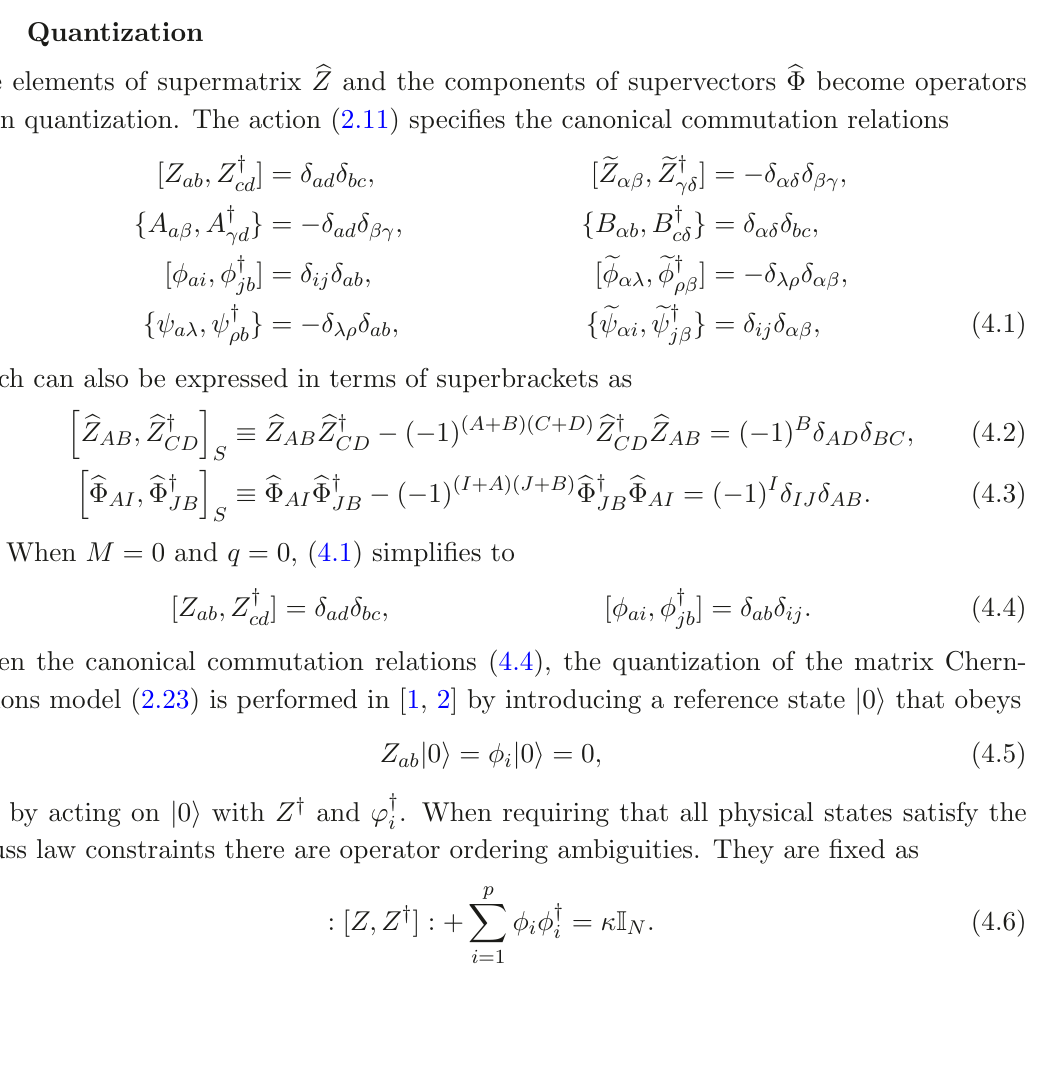
Figure 5 . Antiparallel polarized vortex-antivortex pair ground state. ( N κ ( N M 1) on the plane. The annihilation of M vortex-antivortex pairs a droplet of radius − − releases the energy via the emission of sound p